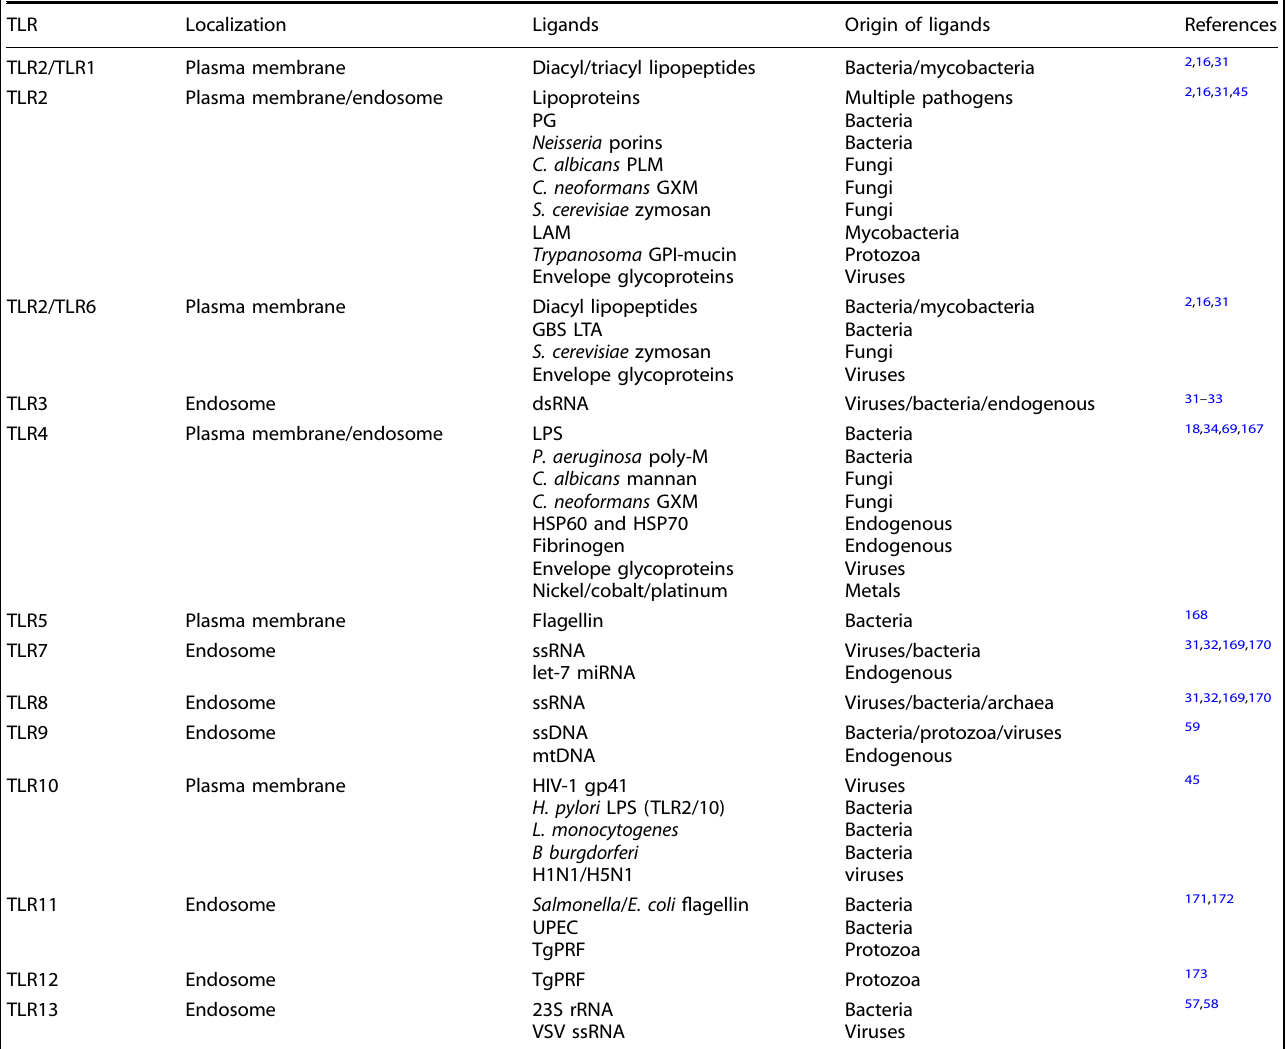
Table 1. Subcellular localization and natural ligands of